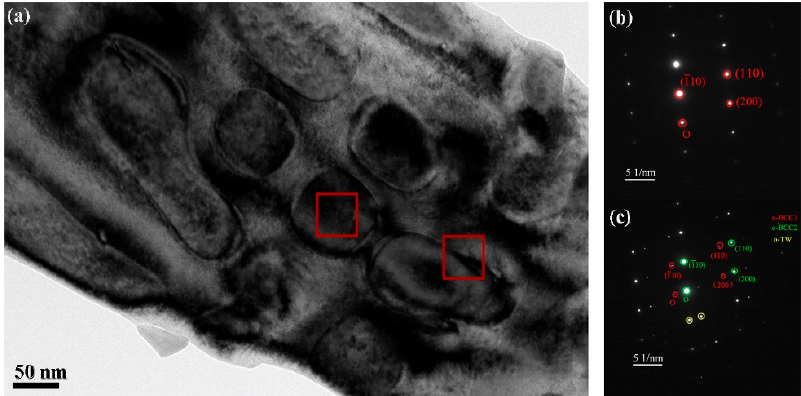
Figure 4. ( a ) corresponding TEM images of the AlCrFeNiV high-entropy alloy with ( b , c ) different electron diffraction patterns. electron diffraction